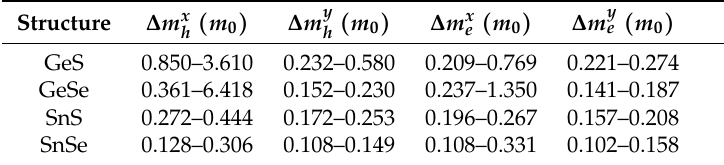
Figure 5. Isosurface plots of the charge density of VBM ( a , b ) and CBM ( c , d ) for monolayer GeS, VBM ( e , f ) and CBM ( g , h ) for monolayer GeSe, VBM ( i , j ) and CBM ( k , l ) for monolayer SnS, VBM ( m , n ) and CBM ( o , p ) for monolayer SnSe illustrated in the bc and ac plane respectively. The isovalue is 0.0085 e/Å 3 . Table 3. Evolution range of effective mass of hole and electron under tensile uniaxial strain of monolayer MX